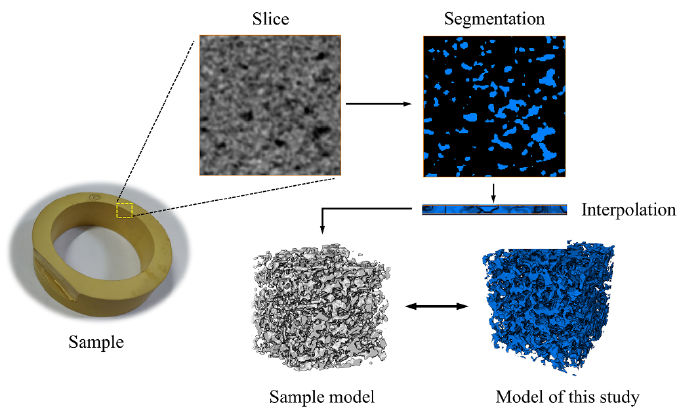
Figure 9. The slice and model of the specimen.